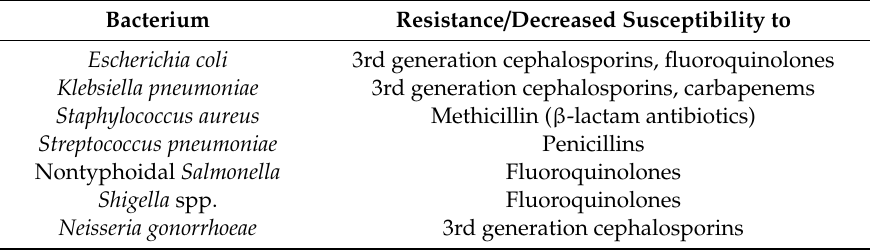
Table 2. Selected bacteria / resistance